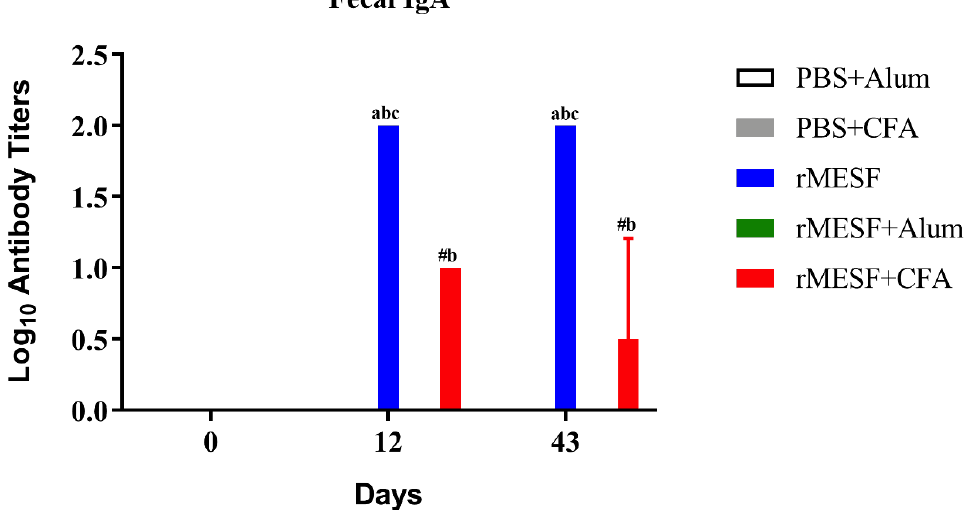
Figure 4. Antibody titers of fecal IgA in controls and immunized mice. Controls, PBS+alum and PBS+CFA. rMESF+alum groups were immunized intramuscular (i.m.). rMESF+CFA were immunized through intradermic route (i.d.) and the first and the second boosters were applied in this group through subcutaneous (s.c.) and i.m. routes, respectively with incomplete Freund’s adjuvant (IFA). rMESF groups were immunized with rMESF alone trough intranasal route (i.n.). The two booster doses were given to all experimental mice groups on the 14th and 28th days. Antibody titers were expressed as mean ± standard deviation (SD) of log 10 of the last inverse serum dilution above cut-off. rMESF+alum group remains below the cut-off value calculated, Symbols and letters indicate statistically significant values of p < 0.0001 as compared with the respective mice group, # vs. PBS+CFA, a vs. PBS+alum, b vs. rMESF +alum, c vs. rMESF +CFA. PBS, phosphate-buffered saline. CFA, complete Freund’s adjuvant.